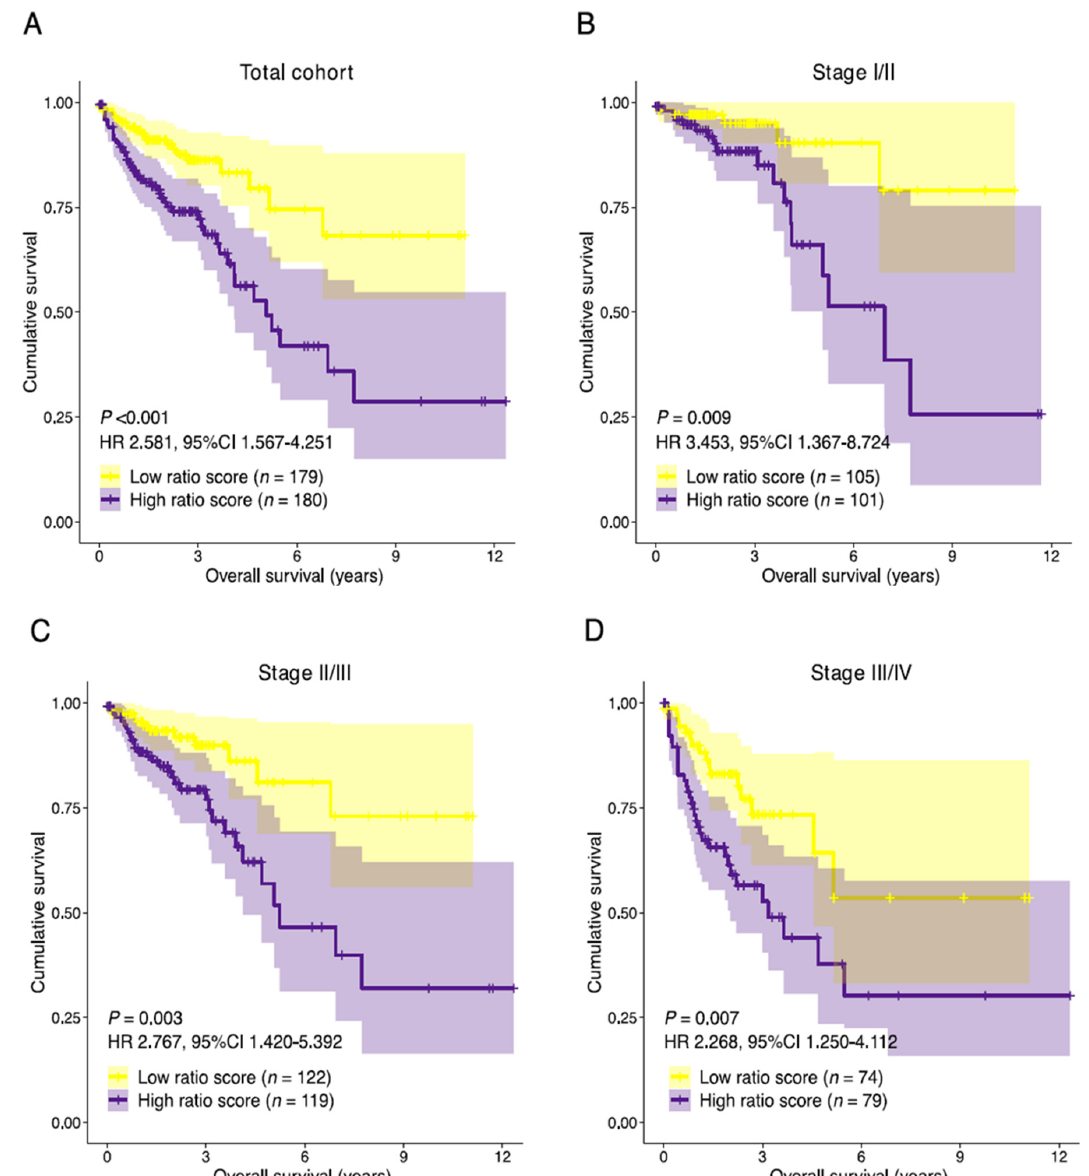
Figure 6. Prognostic performance of the stromal-epithelial signature ratio. Kaplan-Meier curves of the overall survival for the stromal-epithelial ratio-risk scores in ( A ) the total cohort ( n = 359), ( B ) stage I/II ( n = 206), ( C ) stage II/III ( n = 241), and ( D ) stage III/IV ( n = 153) subpopulations. Patients with a high ratio-risk score, categorized by the 50th percentile (median) cut-off, demonstrated a shorter overall survival time. HR, hazard ratio; CI, confidence interval.